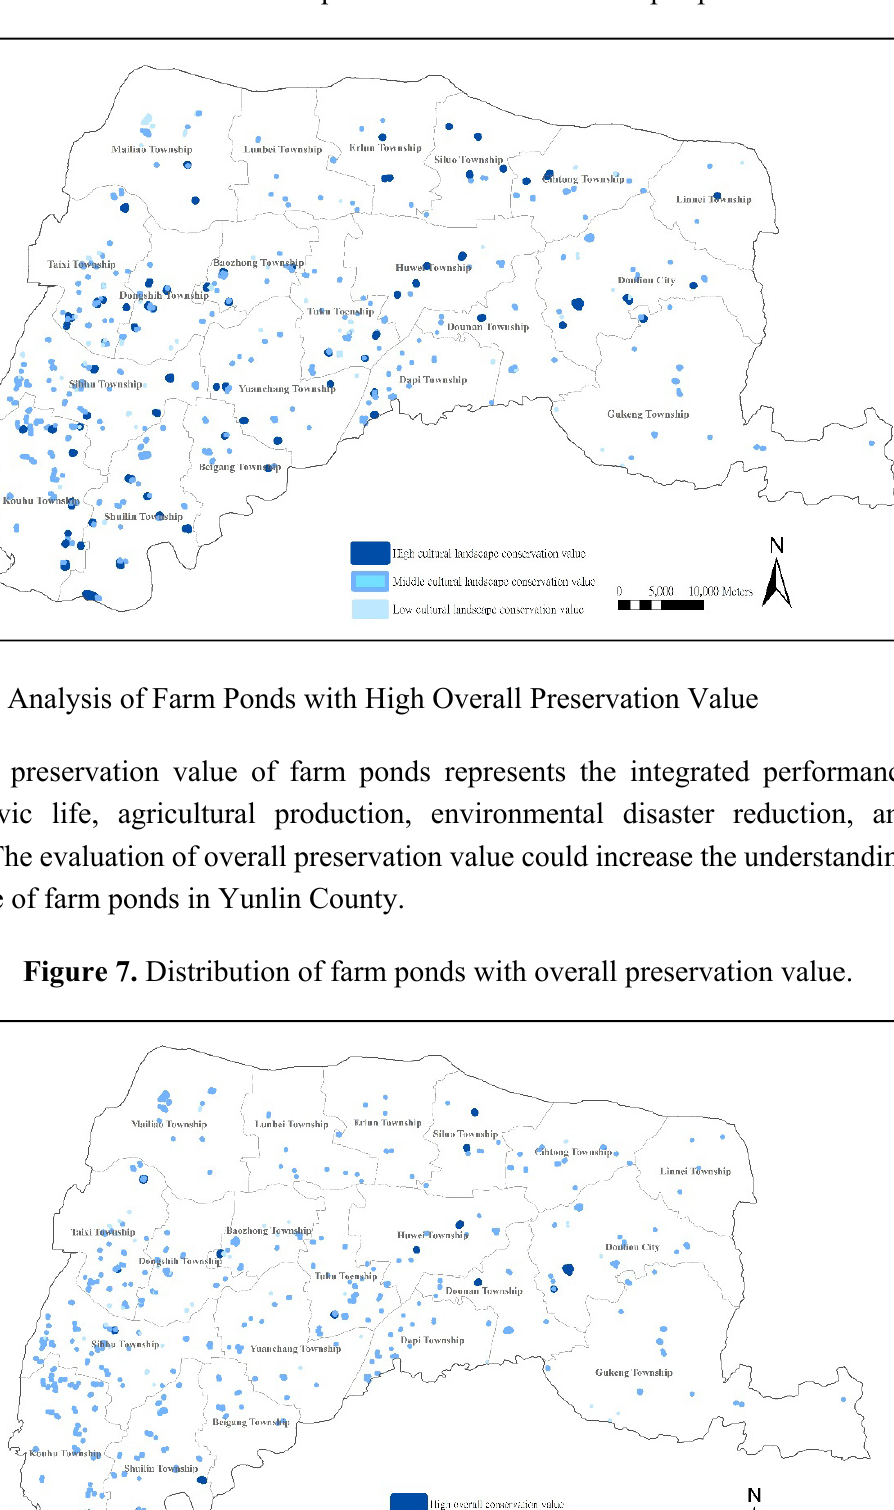
Figure 6. Distribution of farm ponds with cultural landscapes preservation value.